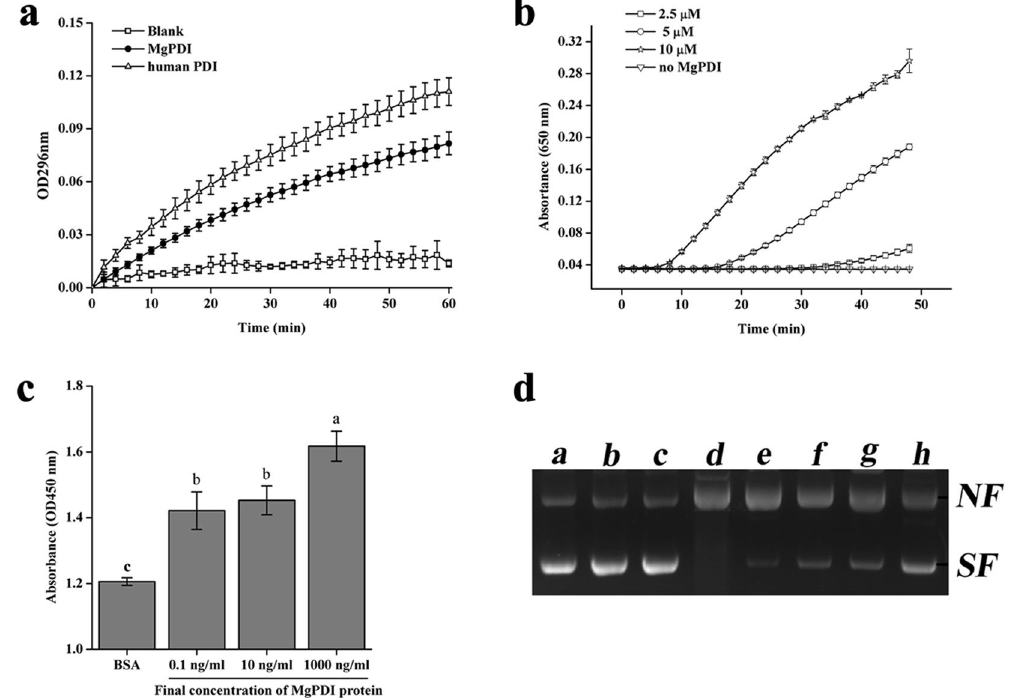
Figure 4. Biological activity of recombinant MgPDI. ( a ) Thiol isomerase activity of the purified recombinant MgPDI. ( b ) Dithiothreitol-mediated insulin reduction by recombinant MgPDI. ( c ) MgPDI protects H 2 O 2 - stressed HEK293 cells. ( d ) Potential of recombinant MgPDI to protect super-coiled DNA from cleavage in an MFO system. Lanes: a, pGEM-T without any treatment; b, pGEM-T incubated with 1.65 mM DTT; c, pGEM-T incubated with 16.5 mM FeCl3; d, pGEM-T incubated with MFO system; e–h, pGEM-T incubated with MFO system and different concentrations of purified MgPDI. NF, nicked form; SF, super-coiled form of pGEM-T. Vertical bars represent the means ±